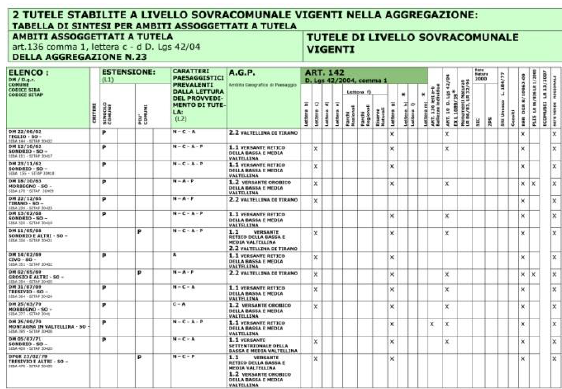
Figure 7. Lombardy PPR, review: Aggregation 23 of bonded areas and sites regarding Valtellina area: landscape preservation summary table derived from the georeferenced